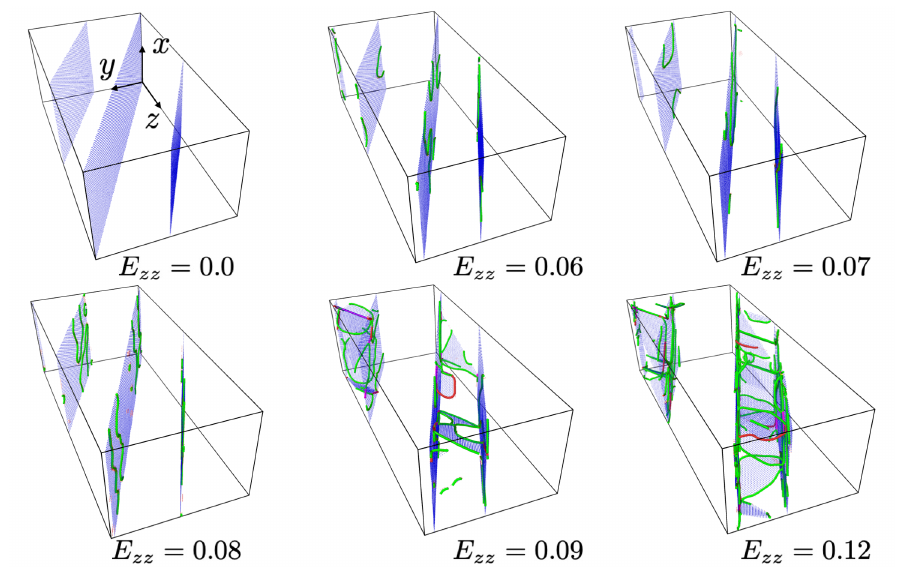
Figure 11. Combined twin boundary motion and bulk dislocation nucleation-slip for θ = 60 ◦ with increasing loading. Blue: twin boundaries and stacking faults. Red: dislocation lines. The dislocations are extracted using the dislocation extraction analysis (DXA) tool in Ovito. For better visualization, fcc lattice atoms have been